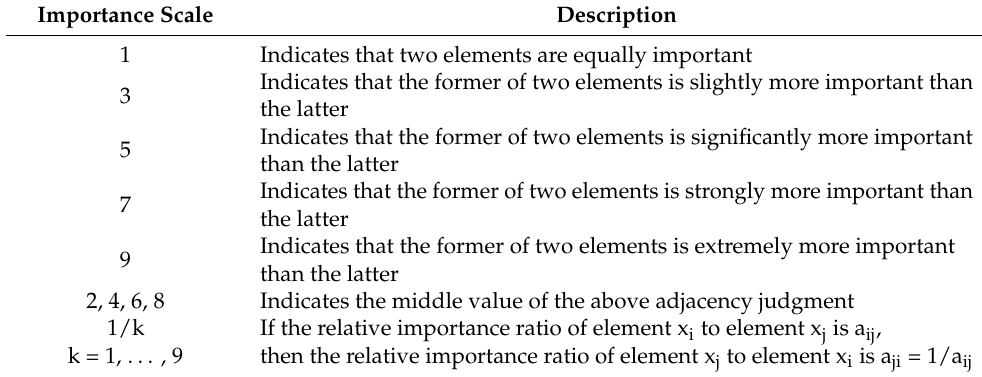
Table 2. 1–9 Scale